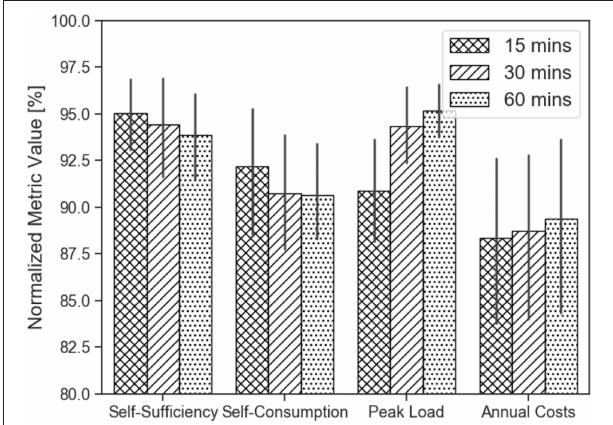
FIGURE 5 | Comparison between different trading intervals at the prosumer level.